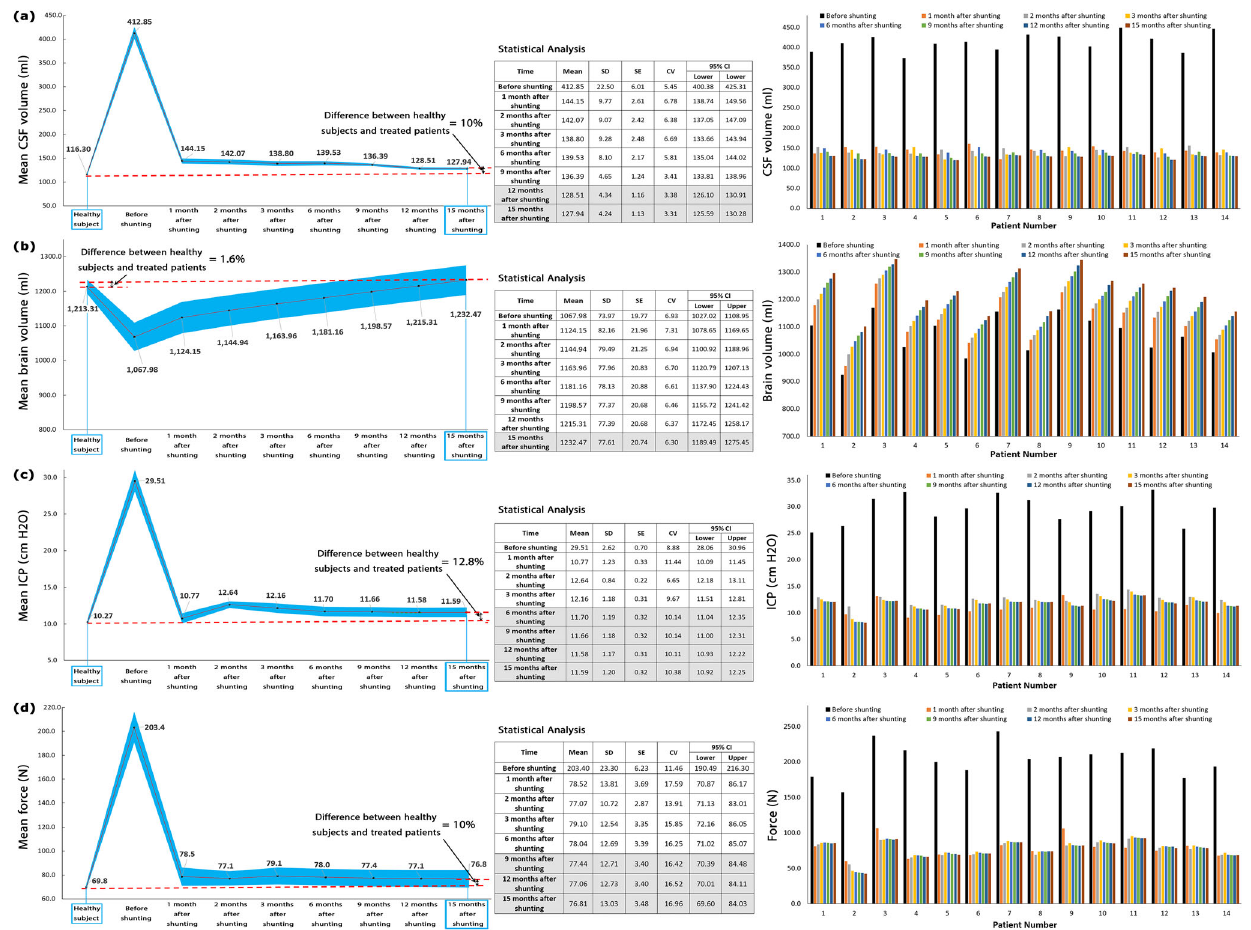
Fig. 2 Changes in volumes of CSF and brain, ICP, and force after shunting. a Mean CSF volume and CSF volumes of all patients before shunting until 15 months after shunting. b Mean brain volume and brain volumes of all patients before shunting until 15 months after shunting. c Mean ICP and ICPs of all patients before shunting until 15 months after shunting. d Mean force and forces in all patients before shunting until 15 months after shunting. It should be noted that the mean volumes, ICP, and force for healthy subjects also showed on the left side panels. The gray areas in statistical analysis tables show the stable areas of volumes, ICP, and fore changes. The CSF volume, brain volume, ICP, and forces values reached stable conditions 12, 15, 6, and 9 months after shunting, respectively. Since the differences between the values of these parameters in stable months were less than 1.0%. Hence, follow-up was stopped 15 months after shunting, and results were reported until the fi fteenth month. Raw data for Fig. 2 is included in Supplementary Data 1. CSF cerebrospinal fl uid, ICP intracranial pressure, SD standard deviation, SE standard error, CV coef fi cient of variation, CI con fi dence of